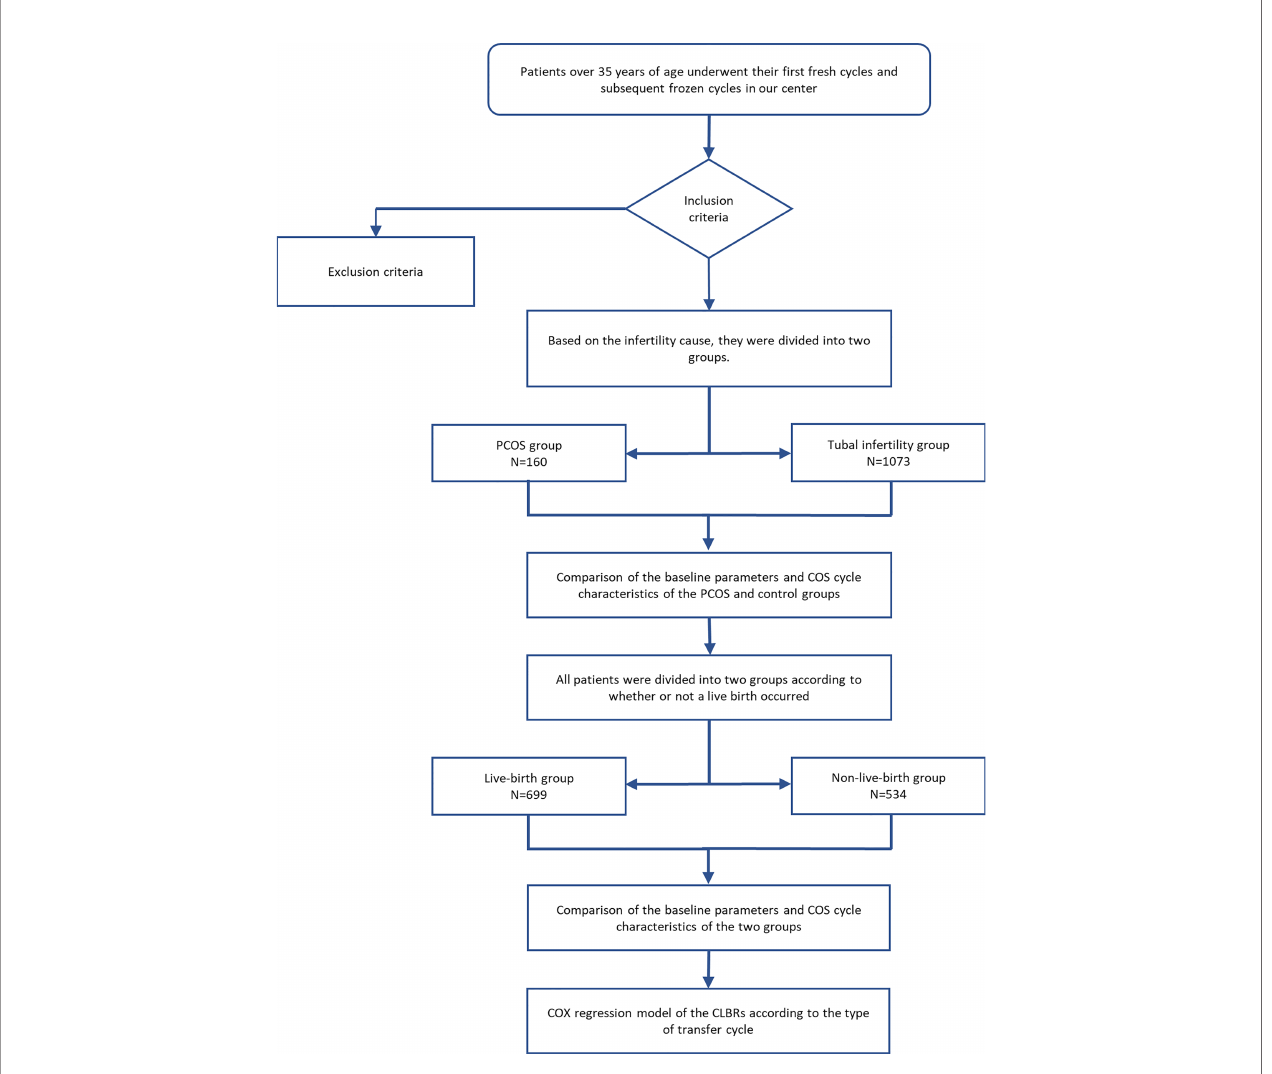
FIGURE 1 | Trial fl ow chart. An overview of the patient selection and